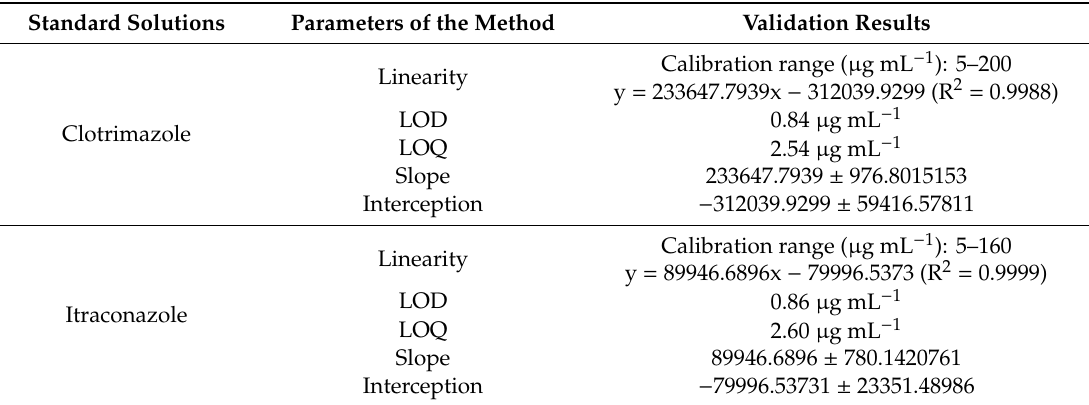
Table 1. Summary of the validation data obtained for the proposed HPLC method developed for the quantification of clotrimazole and itraconazole in microemulsions. LOD—limit of detection; LOQ—limit of quantification.